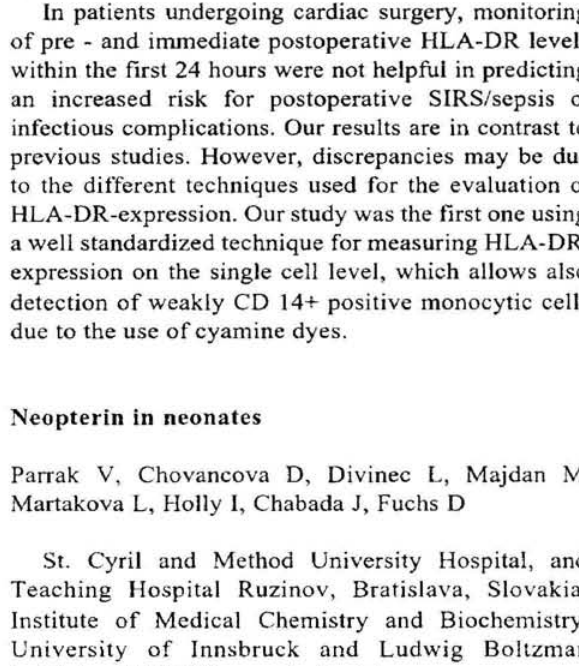
Table 2. Neopterin and procalcitonin concentrations in pairs with infection in the neonate